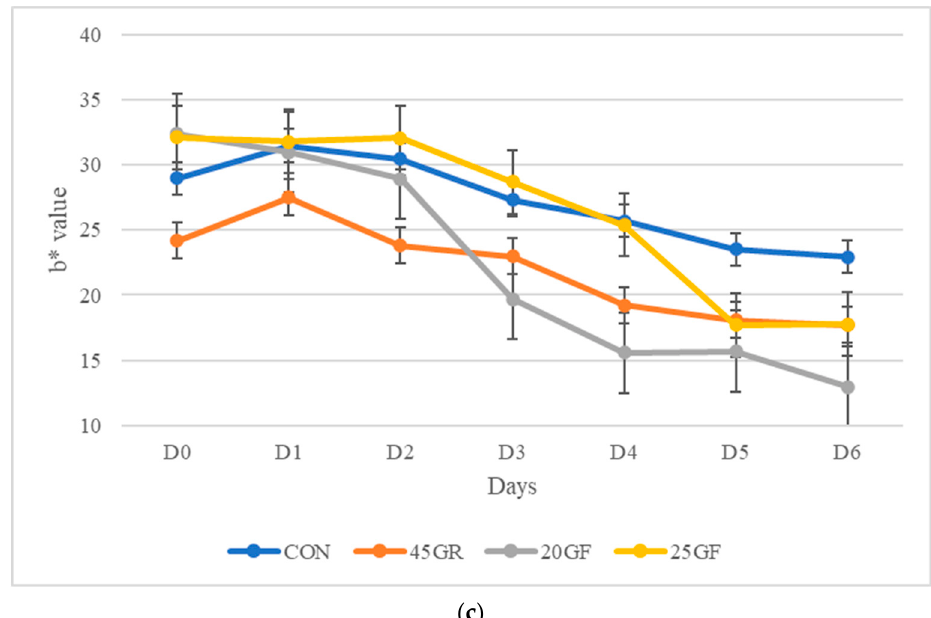
Figure 1. ( a ) Lean muscle L* values (lightness) of steaks over a six-day retail display period from conventional grain-finished beef (CON), 20-months-grass-fed beef (20GF), 20-months-grass-fed + 45-day-grain-finished beef (45GR), and 25-months-grass-fed beef (25GF). Steaks in the CON group possessed higher L* values throughout display time compared to the other groups ( p < 0.05), while the 20GF group possessed the lowest L* values ( p < 0.05). The L* values decreased for all the steaks regardless of treatment group at the end of retail display. ( b ) Lean muscle a* values (redness) of steaks over a six-day retail display period from conventional grain-finished beef (CON), 20-months-grass-fed beef (20GF), 20-months-grass-fed + 45-day-grain finished beef (45GR), and 25-months-grass-fed beef (25GF). After D2, a* values decreased dramatically for the 20GF group ( p < 0.05) while the CON group had the highest a* values towards the end of the display period ( p < 0.05). The a* values decreased for all the steaks regardless of treatment group at the end of retail display. ( c ) Lean muscle b* values (yellowness) of steaks over a six-day retail display period from conventional grain-finished beef (CON), 20-months-grass-fed beef (20GF), 20-months-grass-fed + 45-day-rain-finished beef (45GR), and 25-months-grass-fed beef (25GF). Treatment groups 20GF and 45 GR had the lowest b* values while the CON and 25GF groups had the highest b* values ( p < 0.05). The b* values decreased for all the steaks regardless of treatment group at the end of retail display.